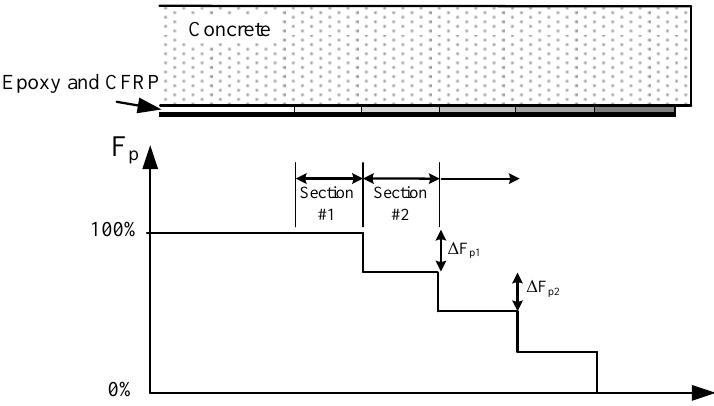
Figure 1. The concept of gradient anchorage, where each section comprises a heating and partial prestress-force-release